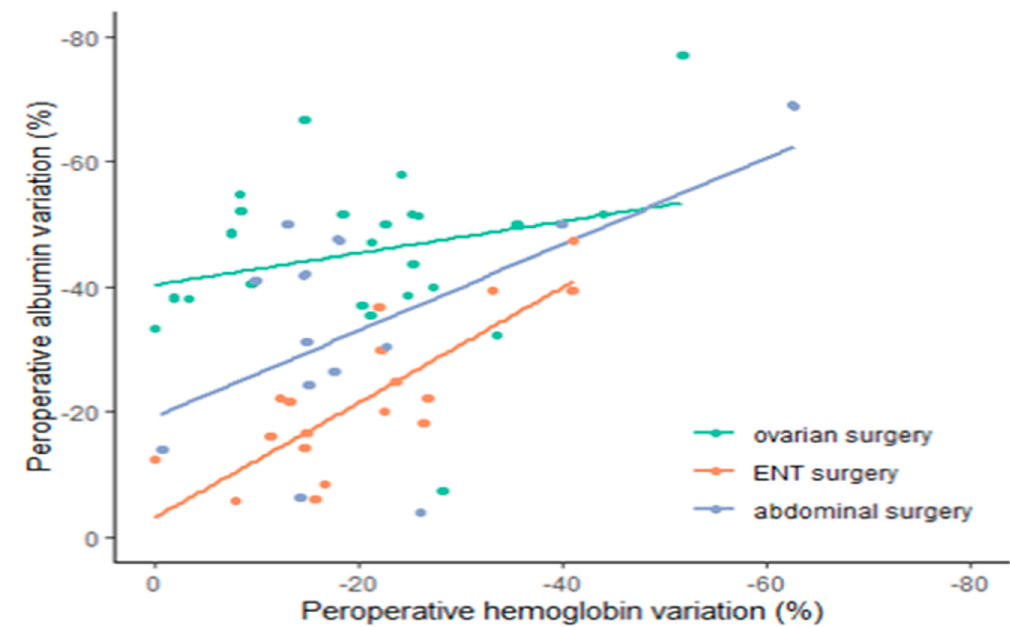
Figure 5. Correlation of albumin and hemoglobin variations.